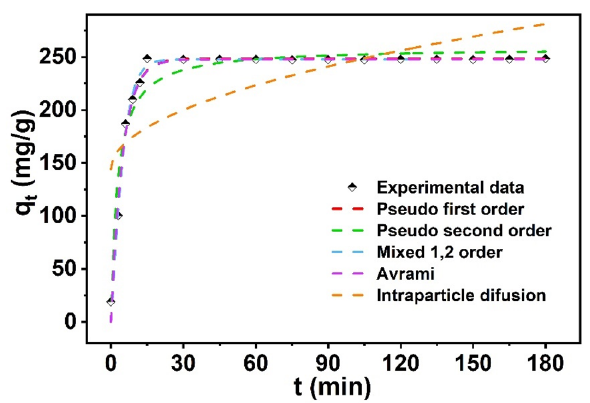
Figure 6. Adsorption kinetic models (C 0 = 100 mg/L, m/V = 0.4 g/L, pH = 5.0 ± 0.1, and T = 298 K).